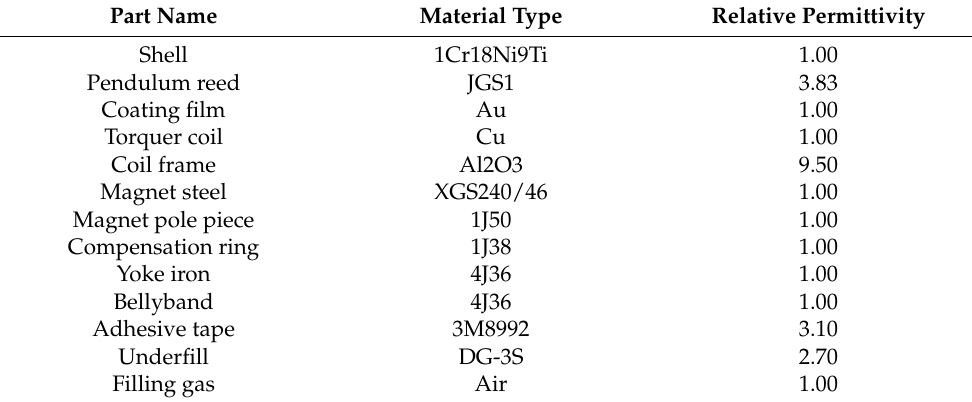
Table 4. Material parameters of components of QFA.